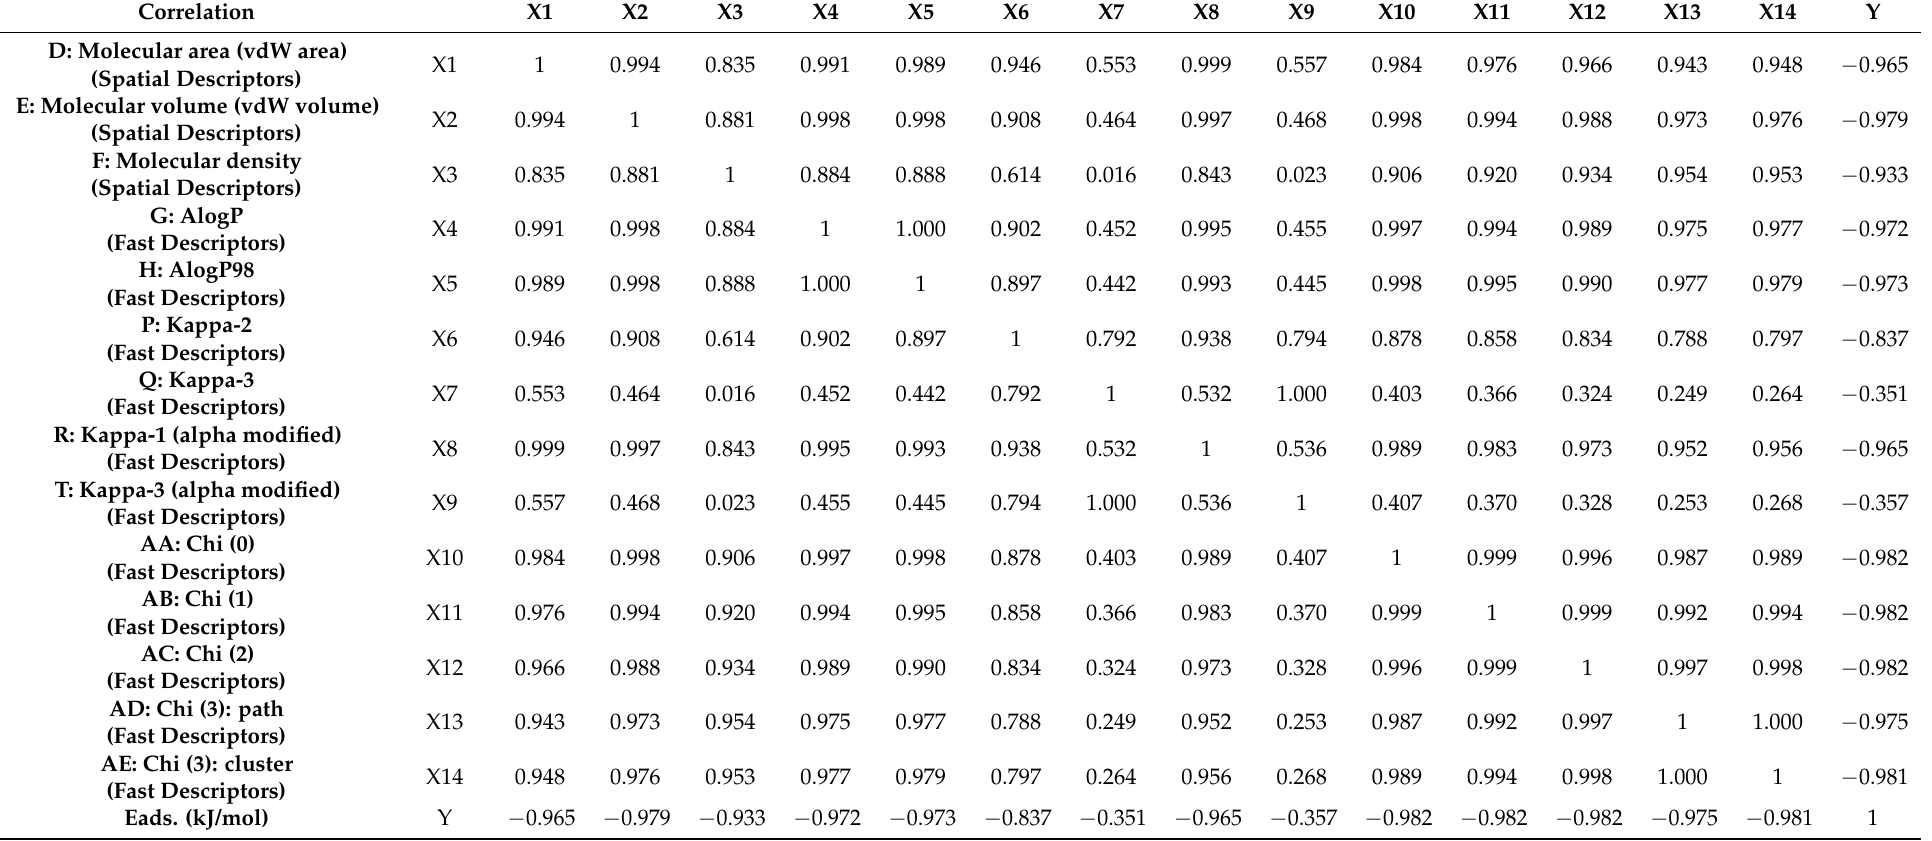
Table 1. The values of several fast and spatial descriptors as calculated from QSAR module in Material Studio